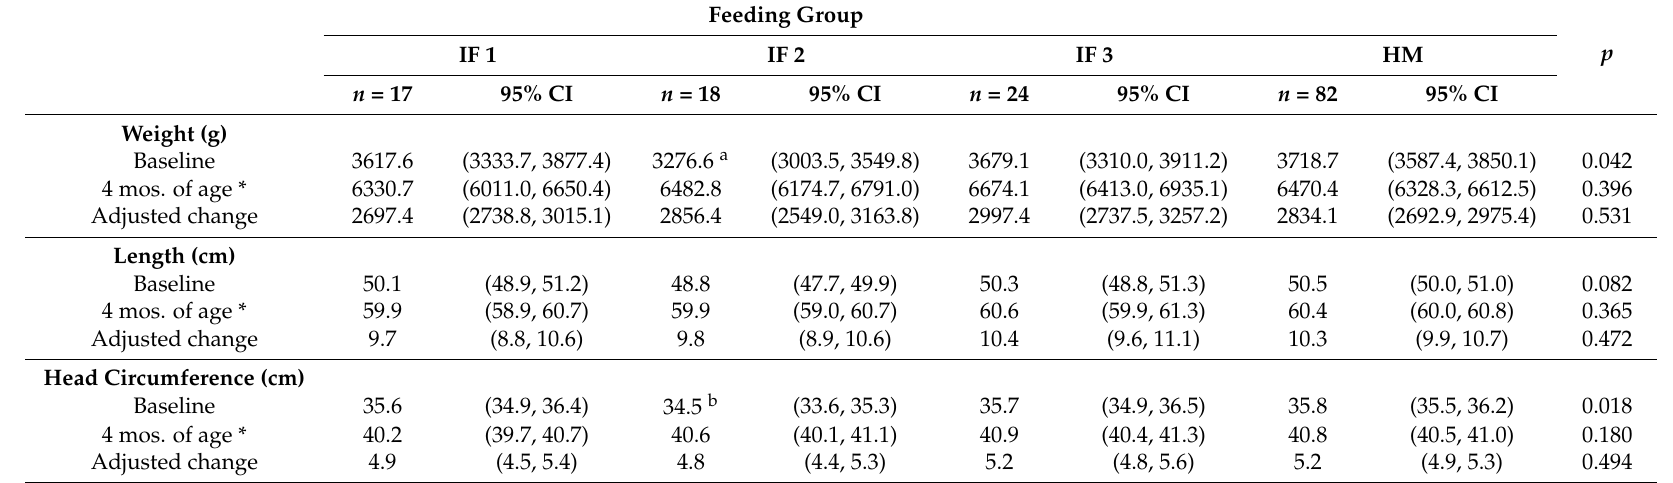
Table 5. Weight, length, and head circumference measurements at baseline, at 4 months of age, and adjusted